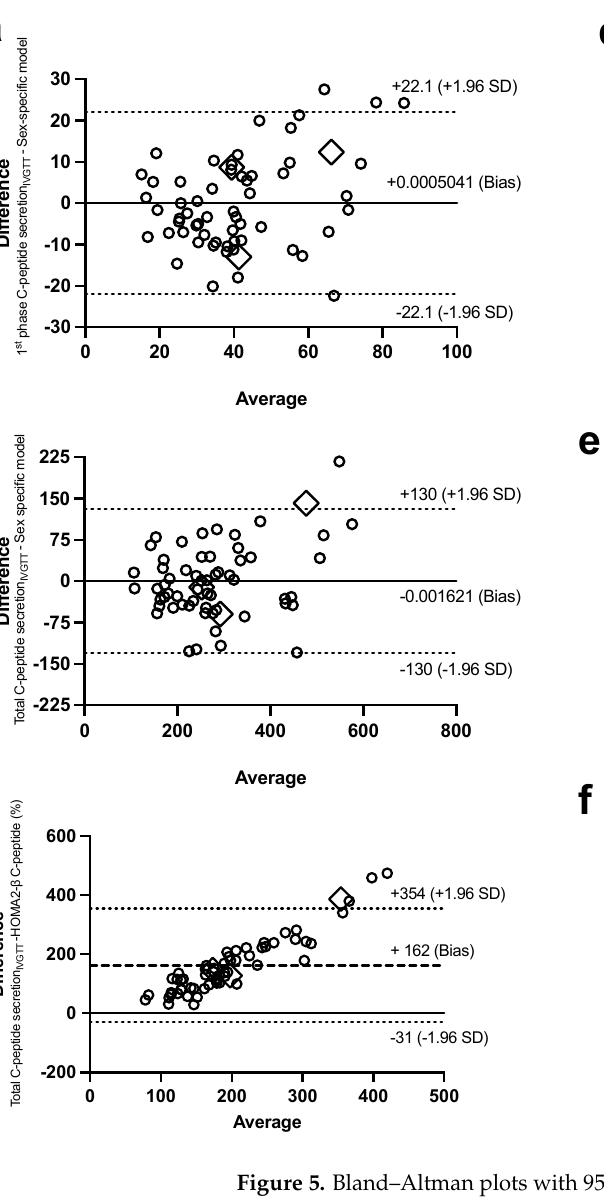
Figure 5. Bland–Altman plots with 95% confidence interval for limits of agreement of the sex-specific models, with their corresponding data for first-phase C-peptide secretion IVGTT in women ( a ) and men ( d ) and total C-peptide secretion IVGTT in women ( b ) and men ( e ), and between HOMA2- β C-peptide , with total C-peptide secretion IVGTT in women ( c ) and men ( f ). Women are in open circles (N = 61, those with BMI > 40 kg/m 2 are in open diamonds) and men are in closed circles (N = 37, those with BMI > 40 kg/m 2 are in closed diamonds).